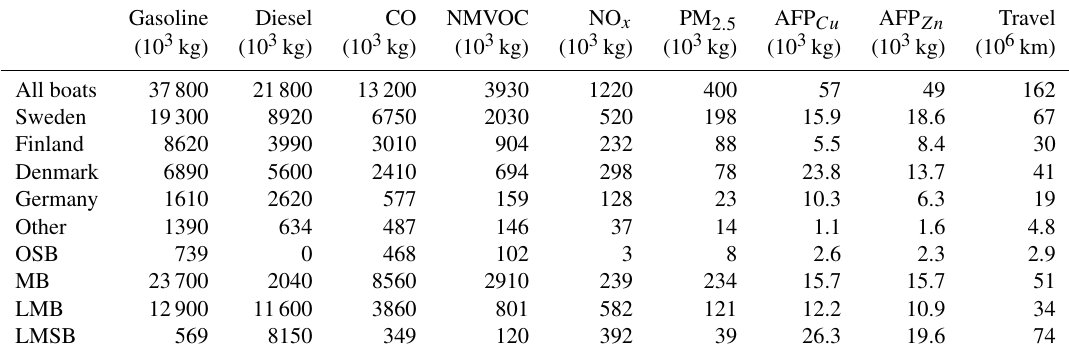
Table 6. Modeled leisure boat fuel consumption, emissions and travel distances in the Baltic Sea, for different flag states and boat types. Flag state category “Other” includes Russia, Estonia, Latvia, Lithuania and